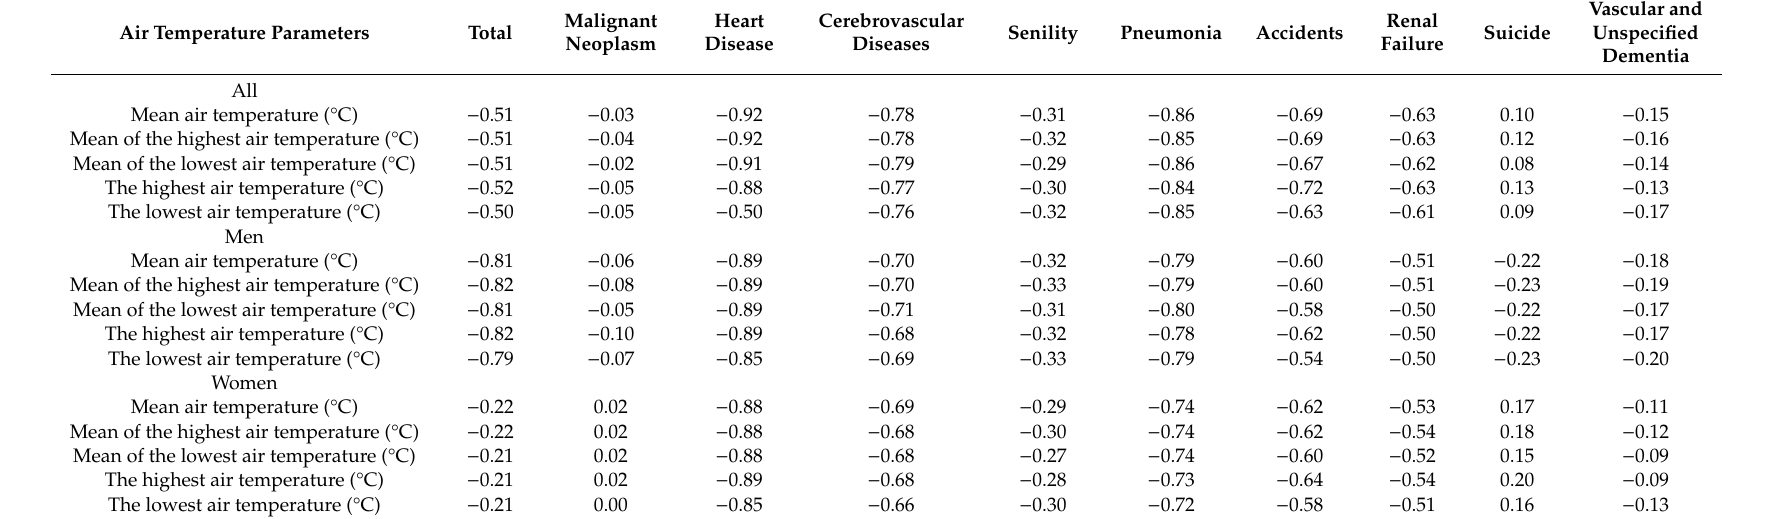
Table 5. Relationship between number of deaths stratified by cause and air temperature parameters according to simple correlation